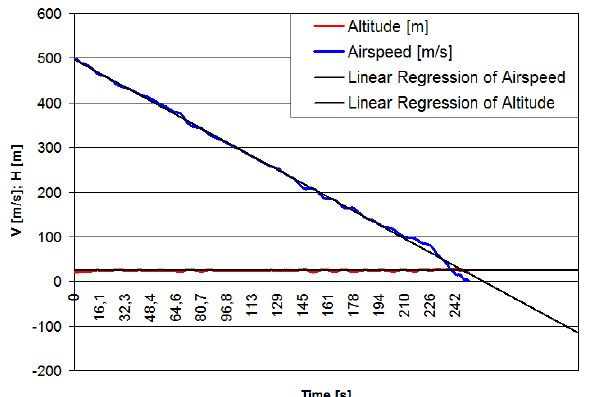
Figure 10. Diagram of In-Flight Measurement of Altitude and Airspeed